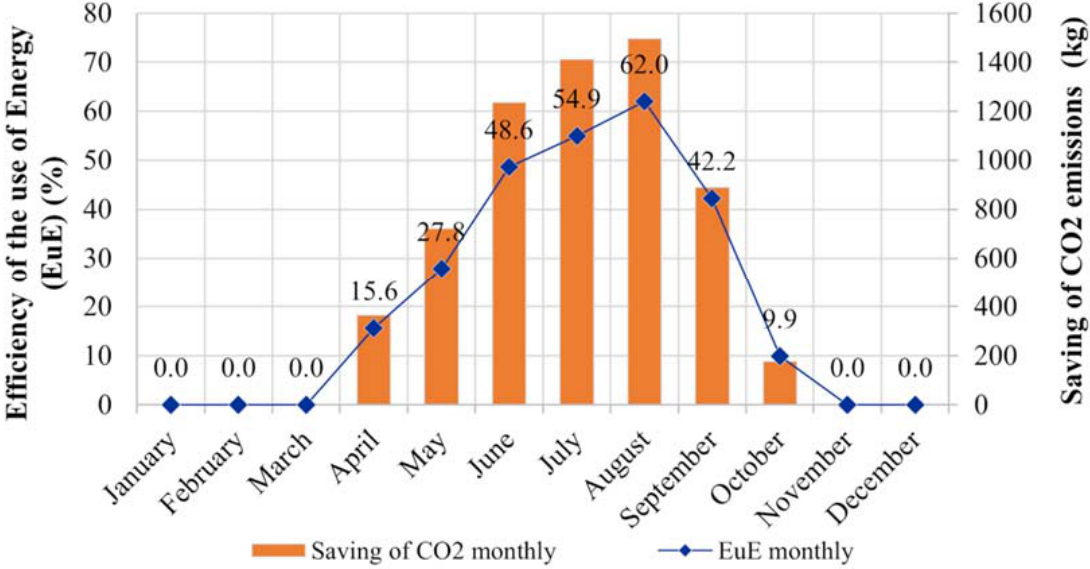
Figure 13. Monthly evolution of the efficiency of the use of energy and the saving of CO 2 emissions throughout the year. Generator made up of 8 strings of 20 panels A ‐ 315M.